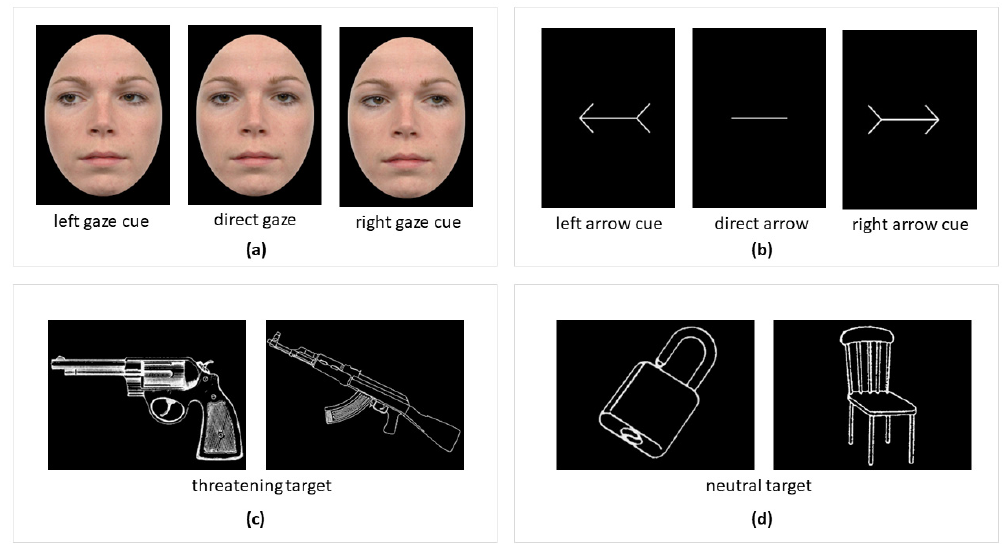
Figure 1. Illustration of the stimuli in the experiment. We used gaze ( a ) and arrow ( b ) stimuli as cues, and threatening objects ( c ) and neutral objects ( d ) as targets.